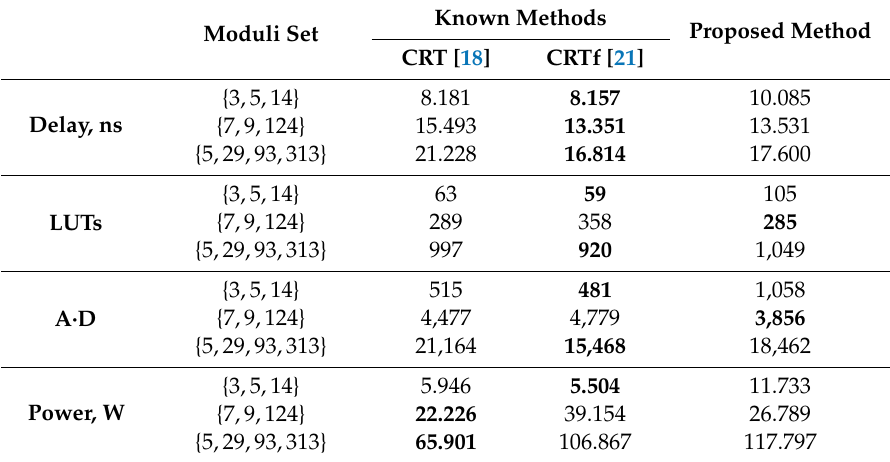
Table 3. Modeling results of the circuit of reverse RNS to binary